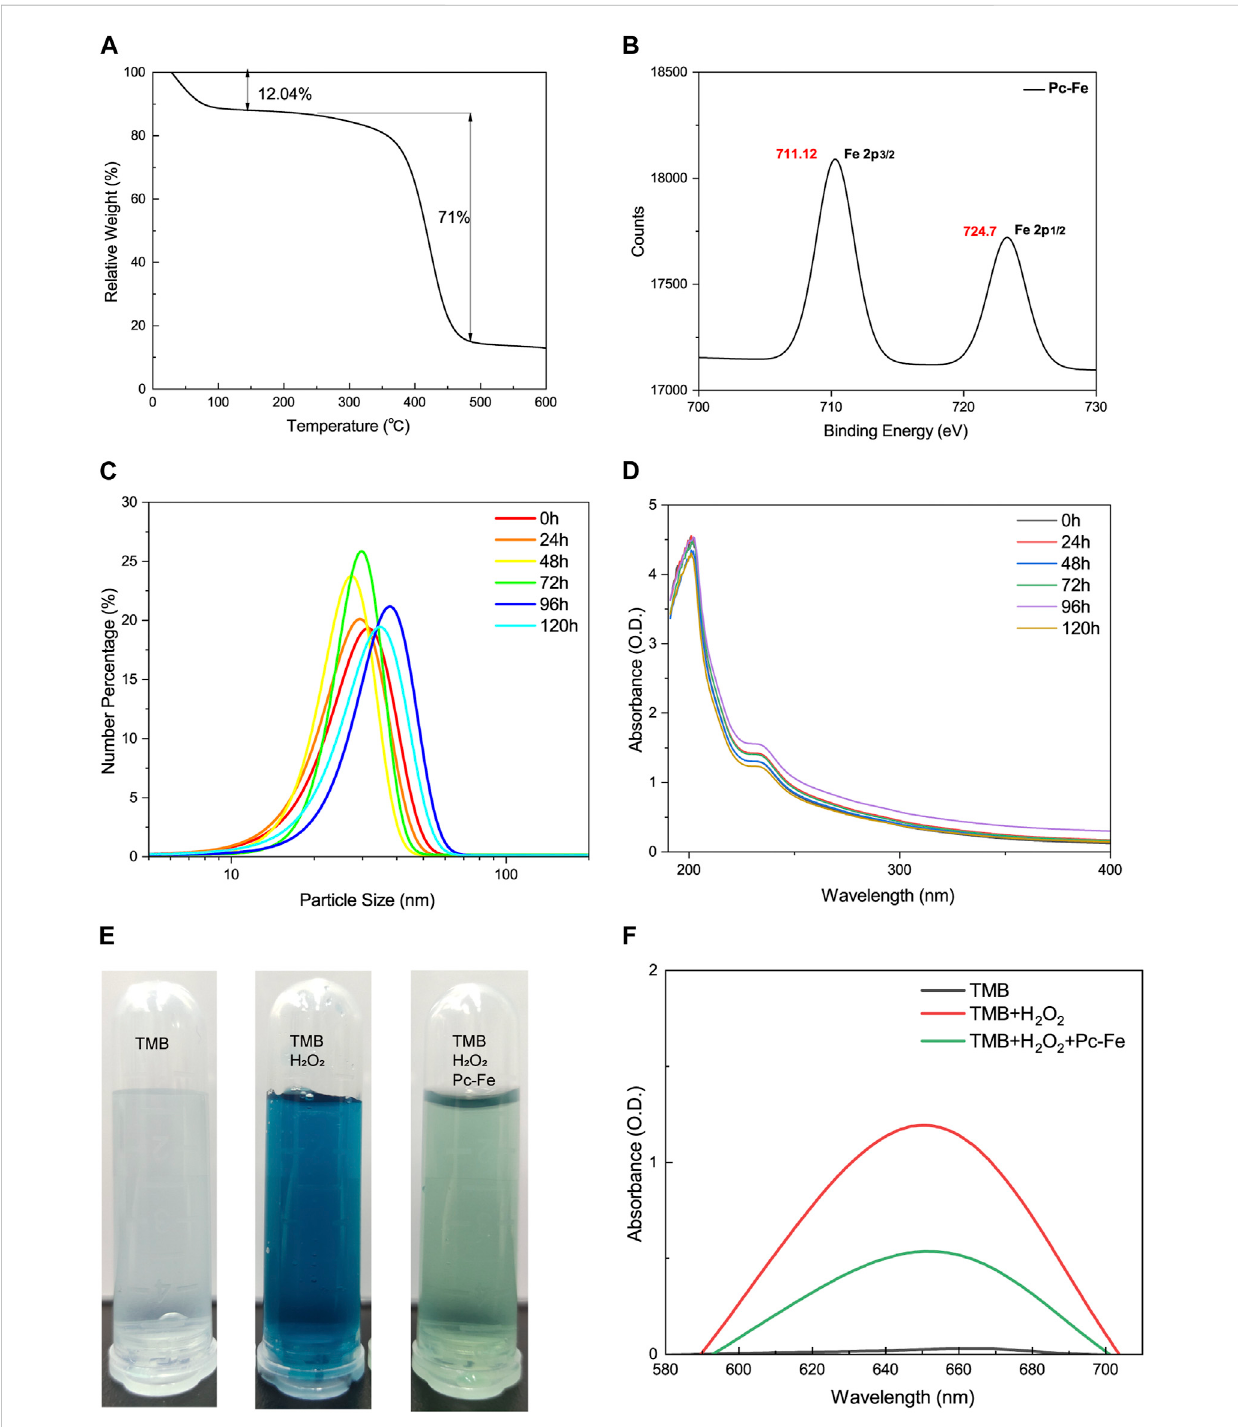
FIGURE 3 CharacterizationsofPc-Fe. (A) Thermogravimetricanalysis ofPc-Fe. (B) XPSspectra ofFeinPc-Fe. (C) SizedistributionsofPc-Fe inpurewater at0, 24, 48, 72, 96, and 120 h. (D) The UV-vis absorbance spectra Pc-Fe at 0, 24, 48, 72, 96, and 120 h. (E) The TMB chromogenic results of Pc-Fe. TMB is colorless and transparent; TMB + H 2 O 2 is dark blue; TMB + H 2 O 2 +Pc-Fe is pale blue. (F) The UV-vis absorbance spectra of TMB with